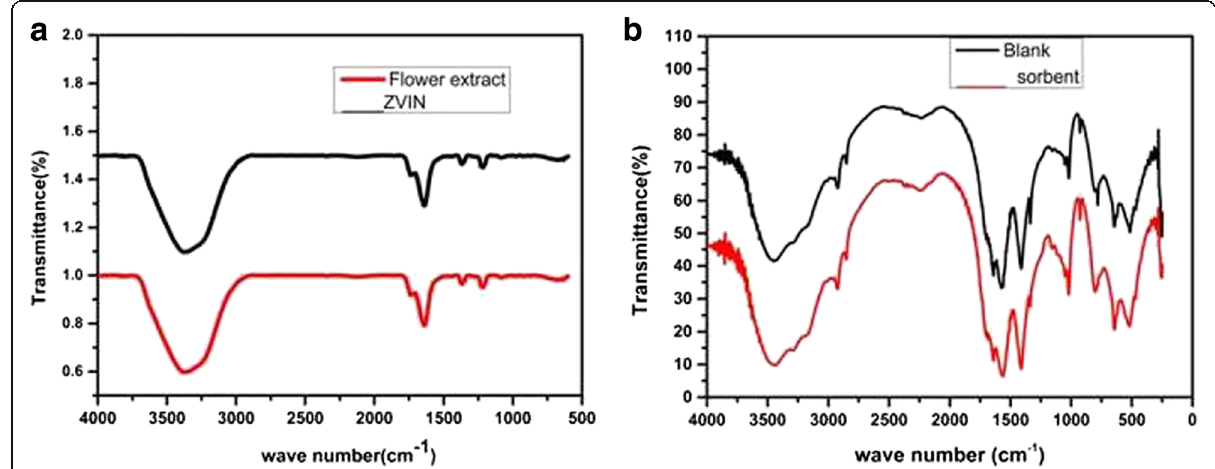
Fig. 2 The FT-IR spectra of a ZVIN and flower extract and b blank and